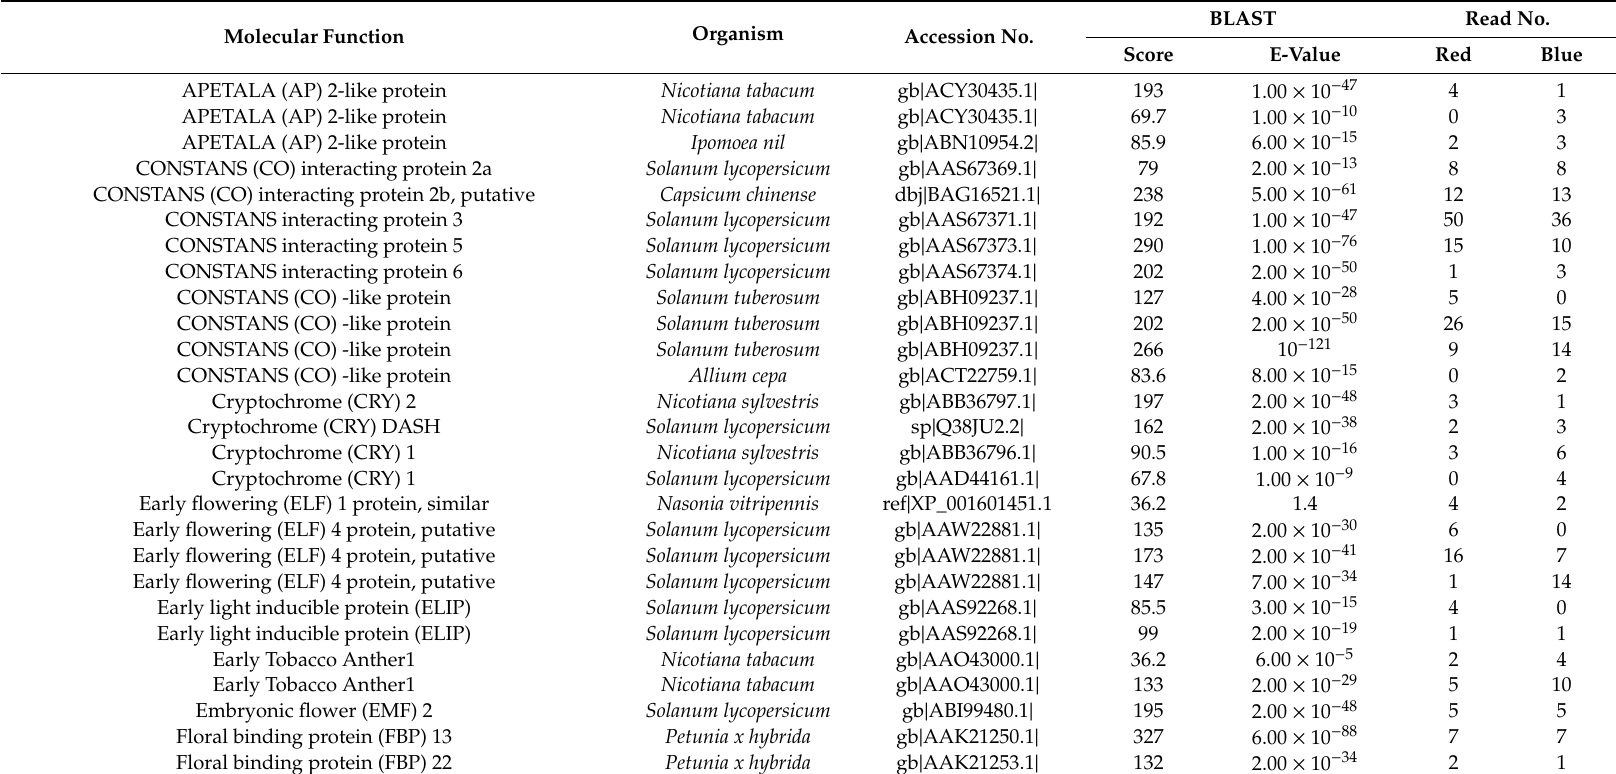
Table 2. Predicted floral induction related genes in petunia detected by 3’EST high throughput sequencing. Molecular